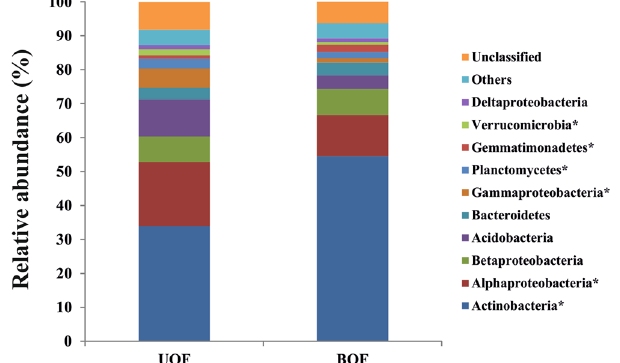
Figure 1. Relative abundances of the dominant bacterial phyla in soils. Relative (%) abundances are based on the proportional frequencies of 16S rRNA gene sequences that could be classified at the phylum level. Asterisks represent a statistically significant difference between UOF and BOF, measured by Fisher’s exact test (p < 0.05). UOF: Undisturbed Oak Forest; BOF: Burned Oak